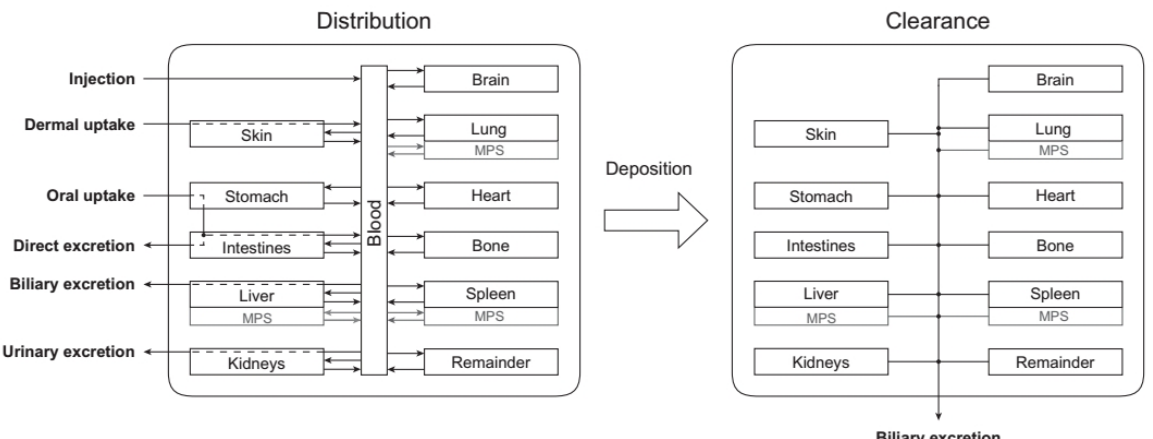
Fig. 6. Schematic diagram of the PBPK model for TiO 2 nanoparticles includes distribution, clearance, and